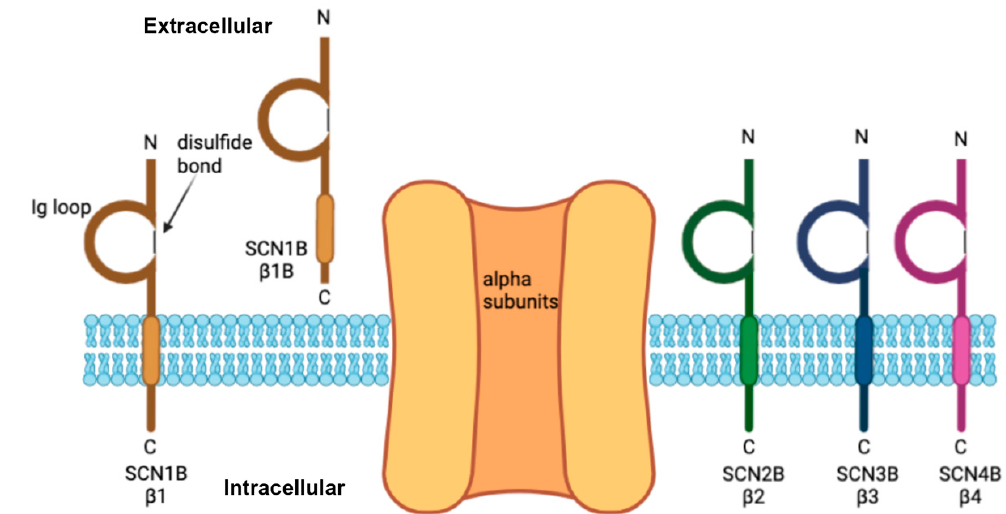
Figure 1. Schematic of the voltage-gated sodium channel b subunits encoded by SCN1B , SCN2B , SCN3B , and SCN4B . The b subunits associate with an alpha (pore-forming) subunit and have an extracellular immunoglobulin (Ig) loop with a single transmembrane domain. b1B is a secreted cell adhesion molecule.